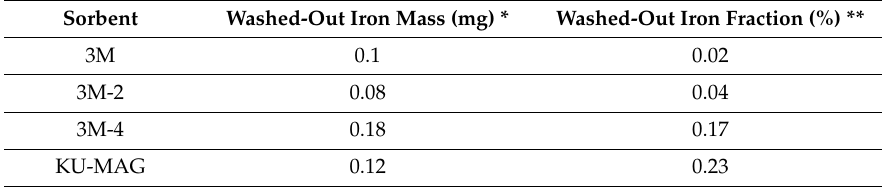
Table 2. Results of estimation of the stability of composite sorbents in NaCl solution (0.1 mol / L).